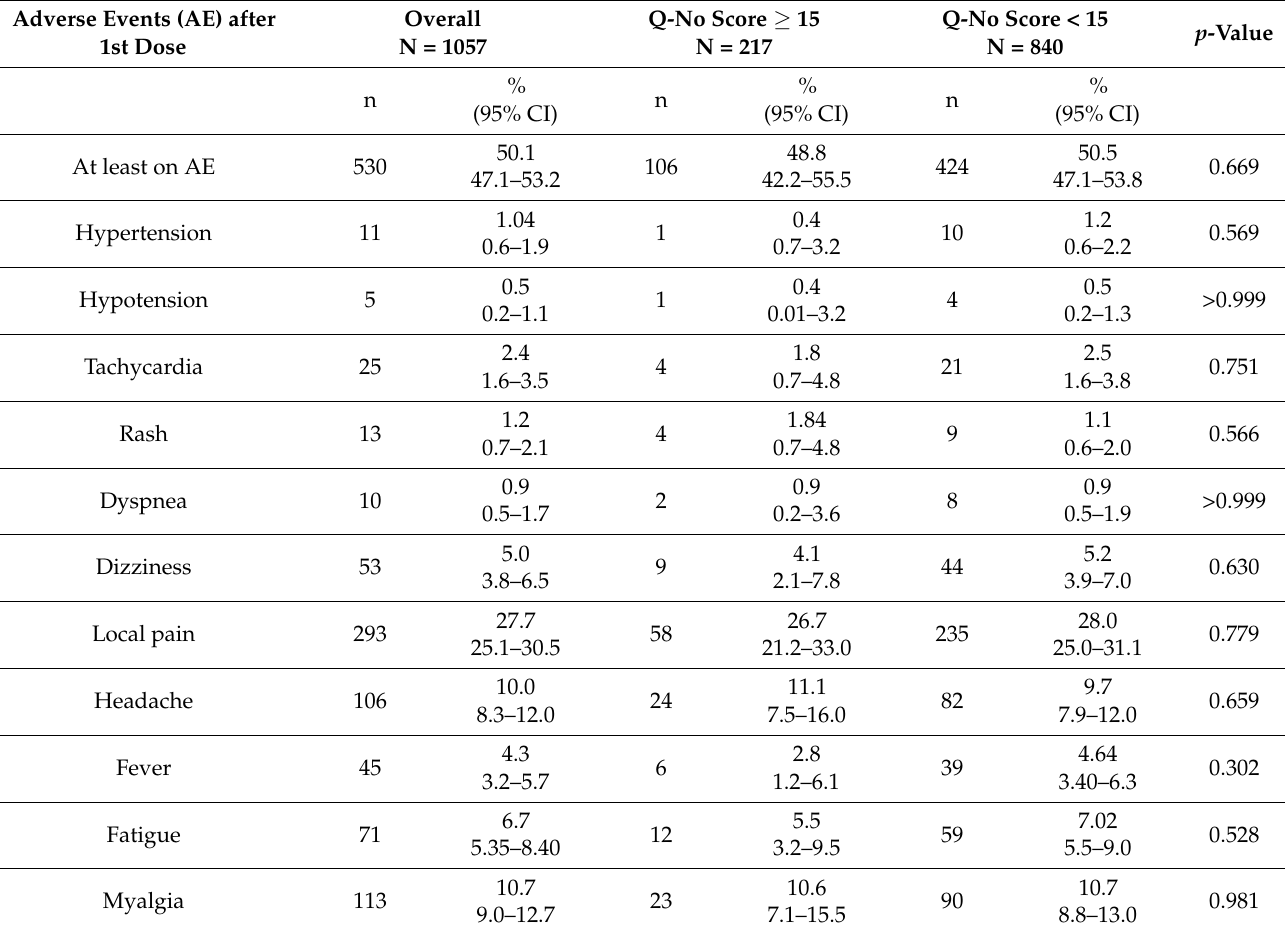
Table 5. Most common reported adverse events after 1st dose by Q-No score.